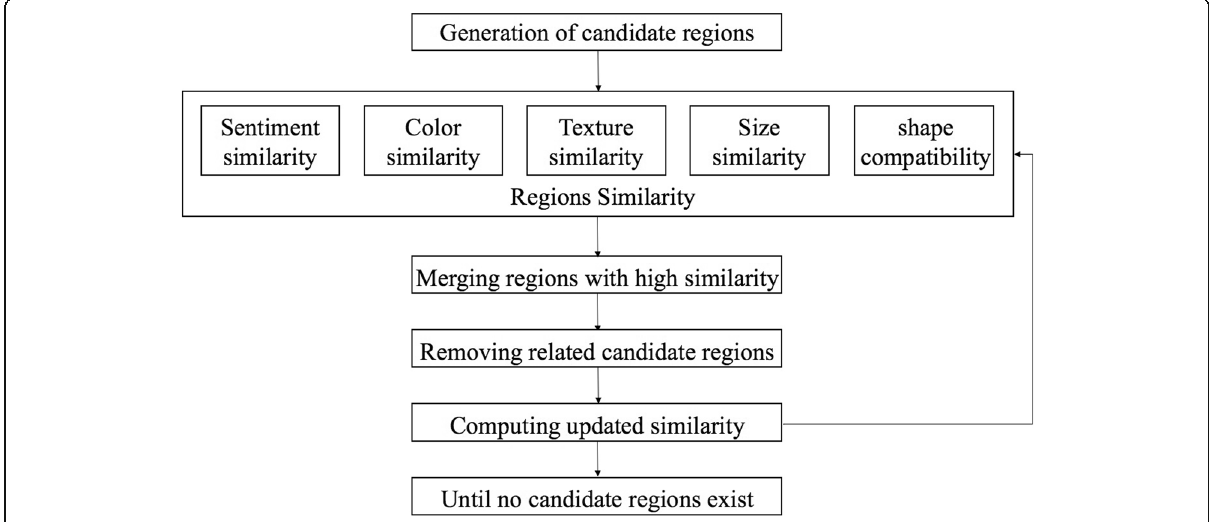
Fig. 2 The detail steps of sentiment region detection